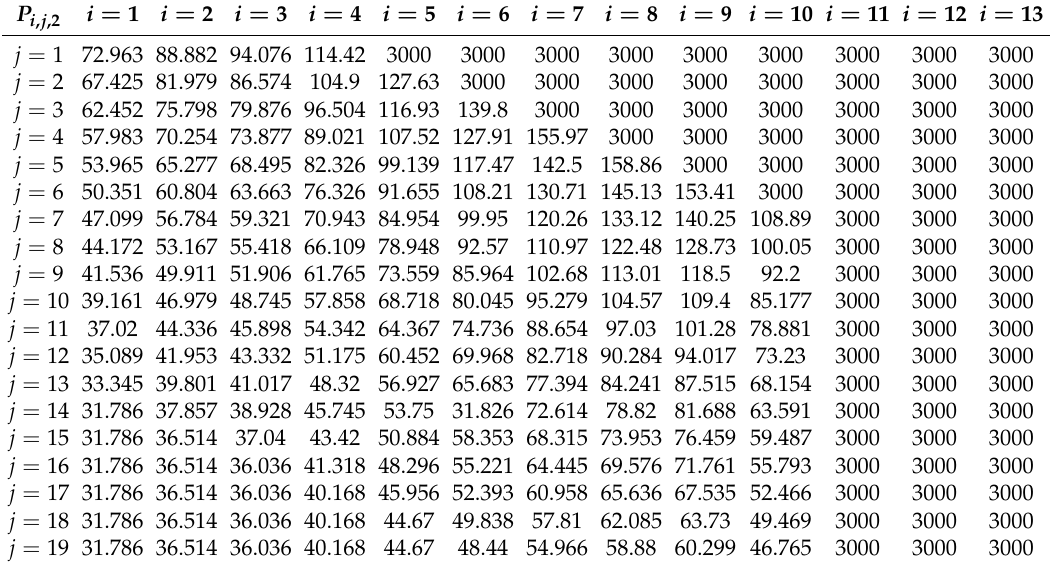
Table A6. Decay heat power of an assembly of LO1-2 belonging to the removal i ∈ I in the period j ∈ J P i , j ,2 .